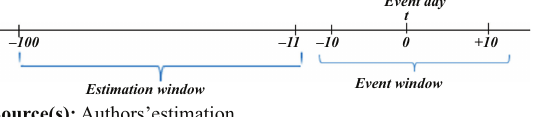
Table 1. Details of the sample